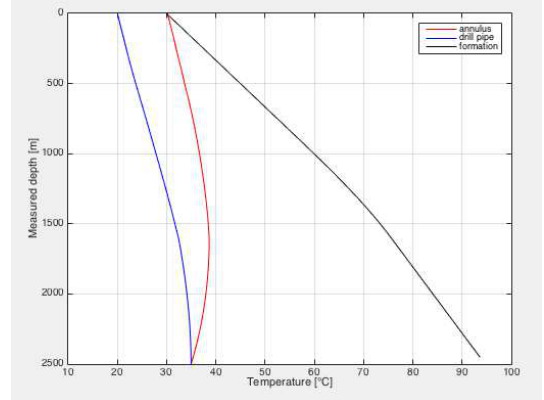
Figure 3: Temperature distribution( Q = 2000 l/min )